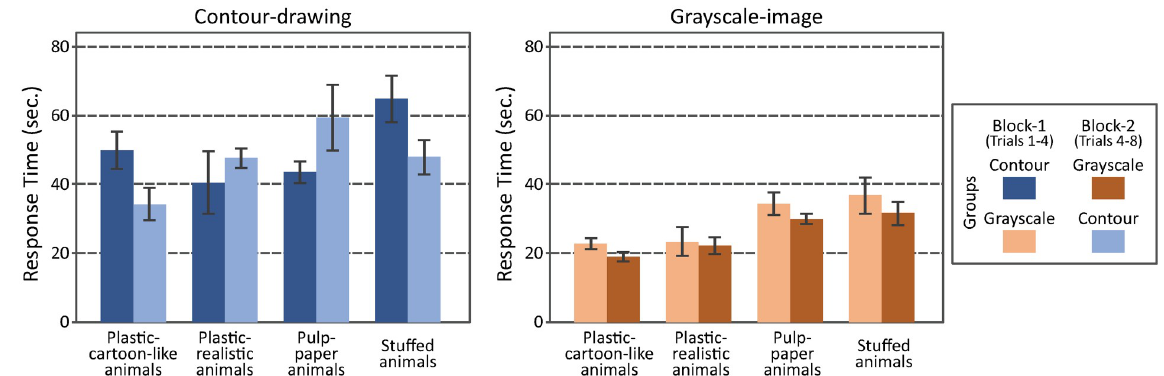
Fig 8. The two panels of bar-graphs show the results obtained with both kinds of filters, i . e ., contour-drawing and grayscale-image. The ordinate shows the response time. The abscissa shows the collections of toy animals. The brightness of the bars represents represent the two groups. The error bars show the standard errors across the participants. The 95 percent confidence intervals based on the t -distribution are 2.45 times of the standard errors ( CDF t − 1 ( p = 0.975, n = 6) = 2.45).